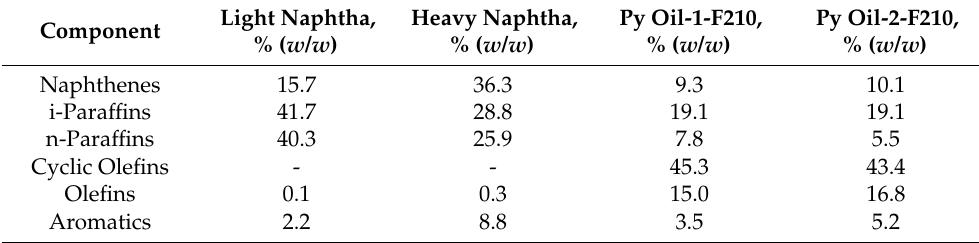
Table 4. PIONA analysis